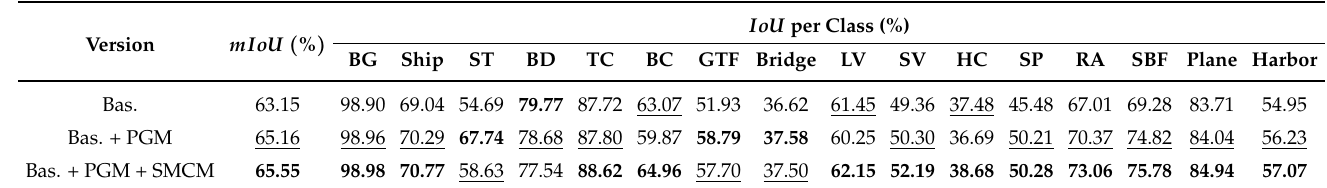
Figure 7. The visualization results of the proposed PGNet and SOTA methods on the ISPRS Vaihin- gen dataset. Table 4. The results of ablation experiments on the iSAID dataset. The best results are highlighted in bold , and the second-best is marked in